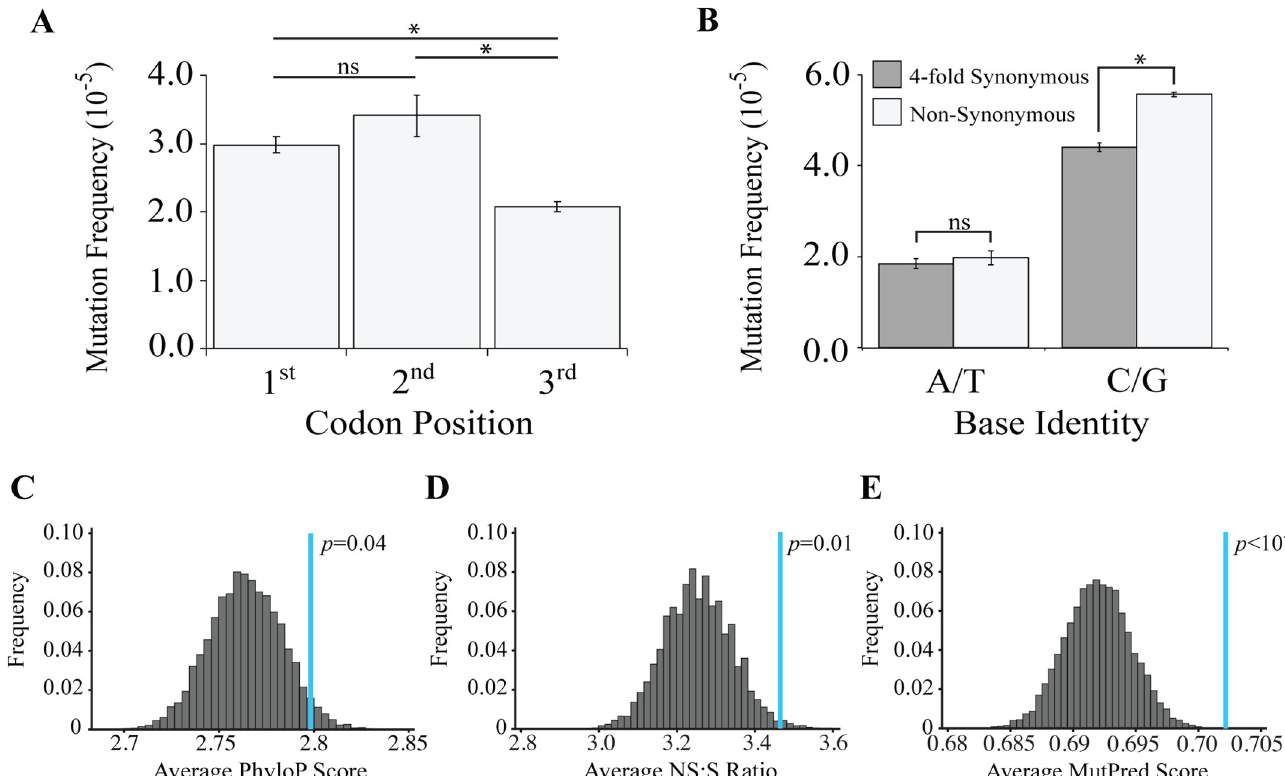
Fig 5. Mutator flies accumulate an excess of deleterious mtDNA mutations. (A) The mutation frequency of 1-day-old 1xPolG mut flies per codon position. (B) The mutation frequency at four-fold degenerate (synonymous; S) and non-synonymous (NS) sites. (C) The distribution of PhyloP scores from 10,000 trials of simulated mutagenesis of the Drosophila mitochondrial genome under conditions of neutrality. The blue line indicates the observed average PhyloP score from 1-day-old 1xPolG mut flies. (D) The distribution of NS/S ratios observed from 10,000 trials of simulated mutagenesis of the Drosophila mitochondrial genome under conditions of neutrality. The blue line indicates the observed average NS/S ratio in 1-day-old 1xPolG mut flies. (E) The distribution of MutPred scores from 10,000 trials of simulated mutagenesis of the Drosophila mitochondrial genome under conditions of neutrality. The blue line indicates the observed average MutPred score in 1-day-old 1xPolG mut flies. p -values for A and B determined through pooled sample Z-test. p -values in panels C-E determined